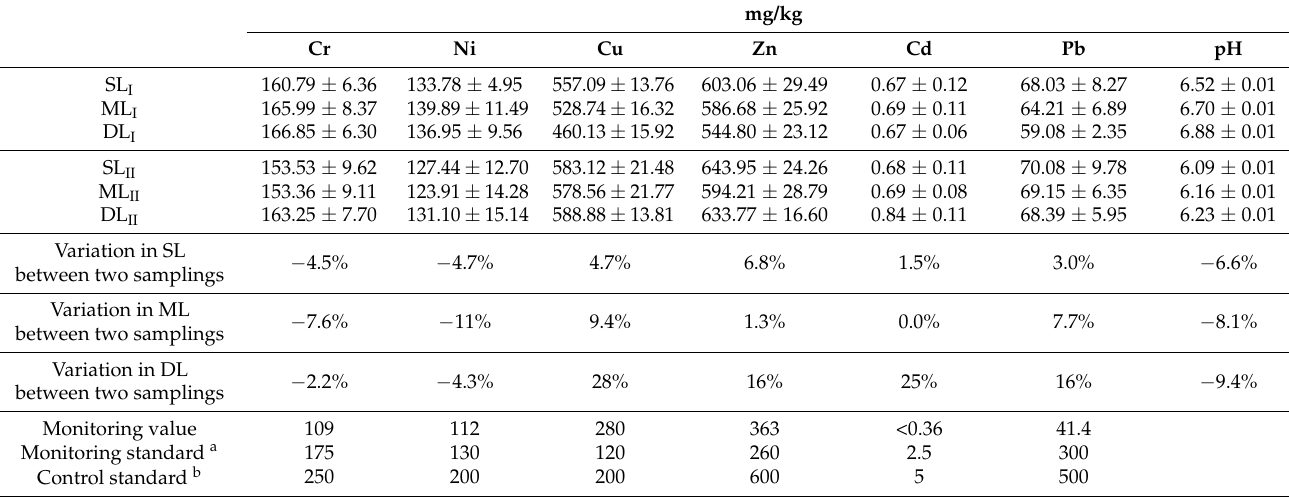
Table 2. The heavy metal concentrations of all soil samples (metals in order of ion